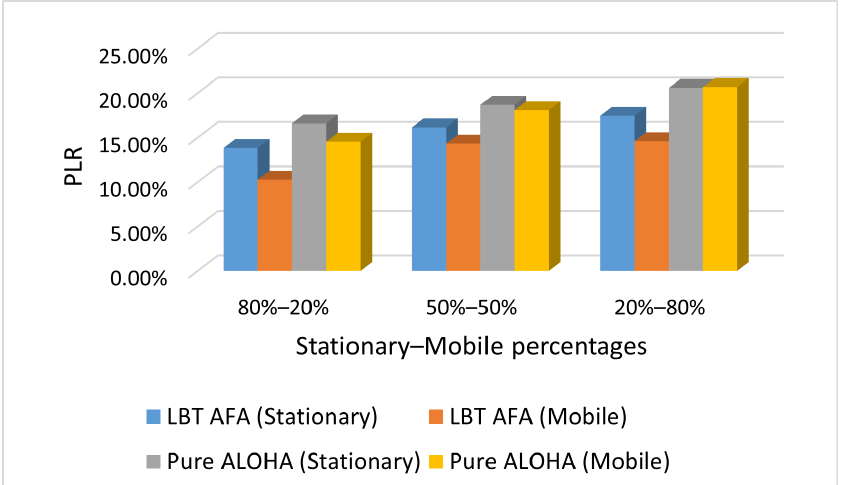
Figure 9. Case H: PLR with varying percentages of stationary and mobile